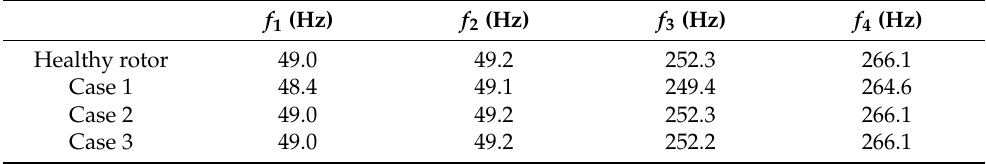
Table 3. Critical speeds of the healthy or cracked rotor